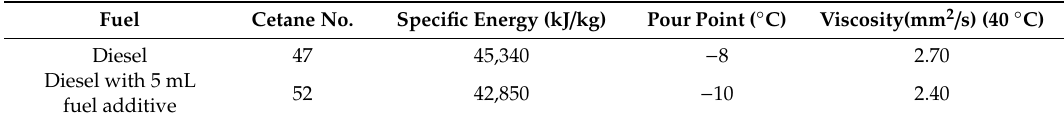
Table 6. Experimental conditions.